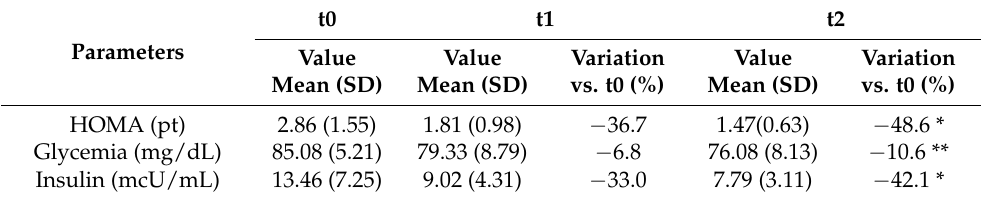
Table 1. Descriptive statistics for the primary endpoint and the glycemic and insulin profiles mea- sured at baseline (t0), after 30 days (t1), and after 60 days (t2) of BBR-PP supplementation.